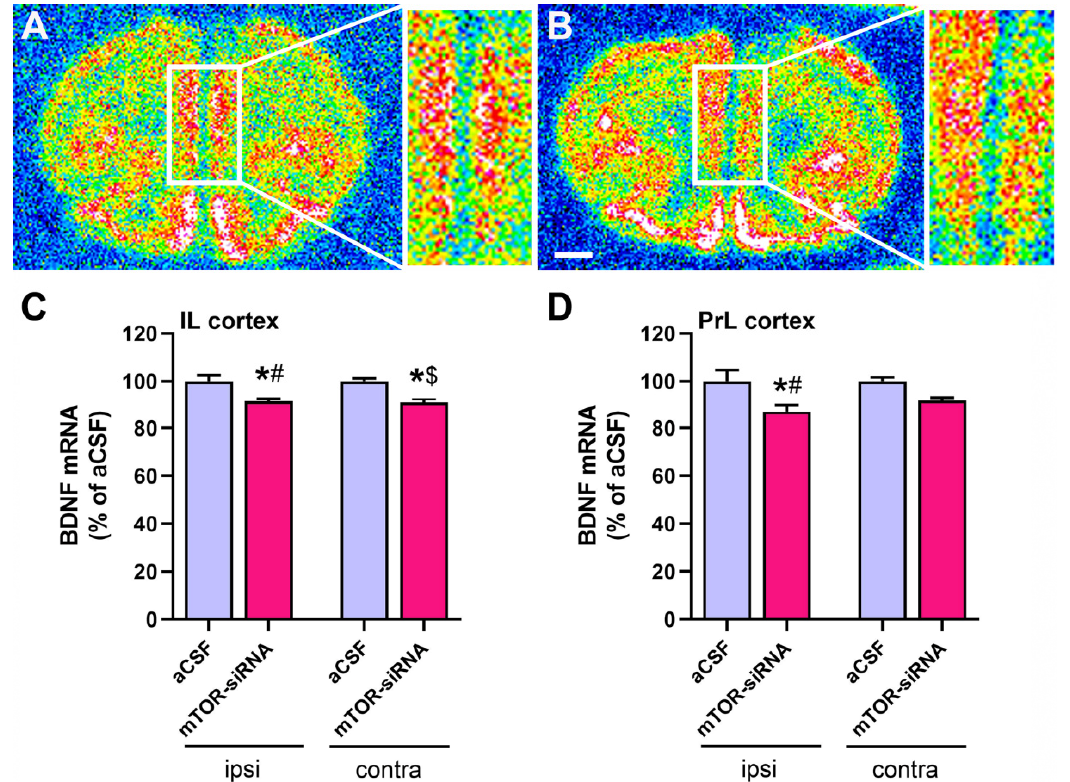
Figure 3. mTOR knockdown in infralimbic cortex reduces BDNF transcription in medial prefrontal cortex. Representative coronal brain sections showing BDNF mRNA expression in ( A ) aCSF-treated and ( B ) mTOR-siRNA-treated mice, as assessed by in situ hybridization. Effect of local mTOR-siRNAs infusion in the IL cortex on BDNF mRNA expression in the mPFC: ( C ) IL and ( D ) PrL areas. Data are expressed as mean ± S.E.M. Two-way ANOVA followed by a Bonferroni post hoc test, * p < 0.05 compared to their respective aCSF group; # p < 0.05 compared to the contralateral aCSF group; $ p < 0.05 compared to the ipsilateral aCSF group. n = 5 animals per group. Scale bar: 1 mm. aCSF: artificial cerebrospinal fluid; BDNF: brain-derived neurotrophic factor; contra: contralateral to the infusion site; ipsi: ipsilateral to the infusion site; IL: infralimbic; PrL: prelimbic; siRNA: small interfering RNA.